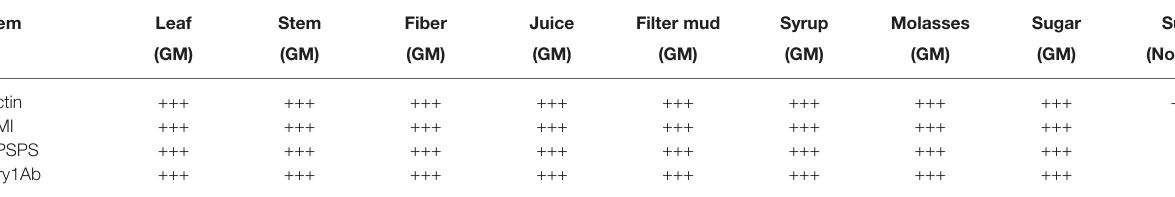
TABLE 5 | RT-qPCR analysis of all DNA samples.